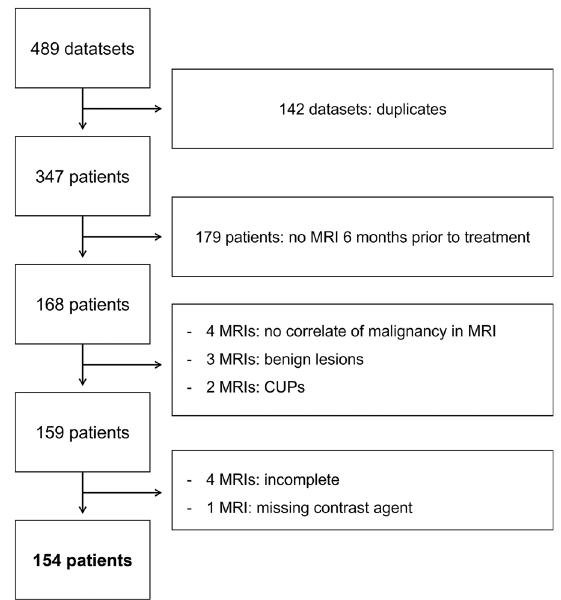
Fig. 1 Selection of study population. Initially, we identified datasets of patients with breast cancer who underwent initial or follow-up DCE-MRI at our department in 2018 and 2019. After exclusion of duplicate datasets, necessary when patients underwent multiple breast MRI examinations during the study period, further criteria had to be met, including a pretreatment DCE-MRI within 6 months of initial diagnosis. CUP Cancer of unknown